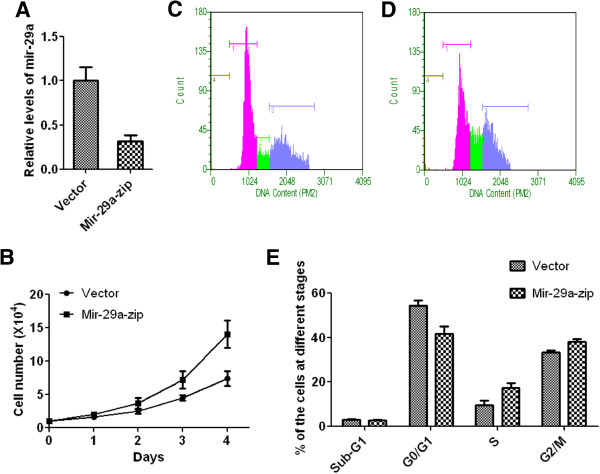
Knockdown of miR-29a in MCF-10A cells increases growth of cells. A, relative levels of mir-29a in cells with or without mir-29a knockdown, n = 5, Mean ± SD. B, the growth curve of above cells, n = 5, Mean ± SD. C and D, representative figures of cell cycle analysis using Guava assay. E, quantitative analysis of the results of cell cycle examination, n = 5, Mean ± SD.